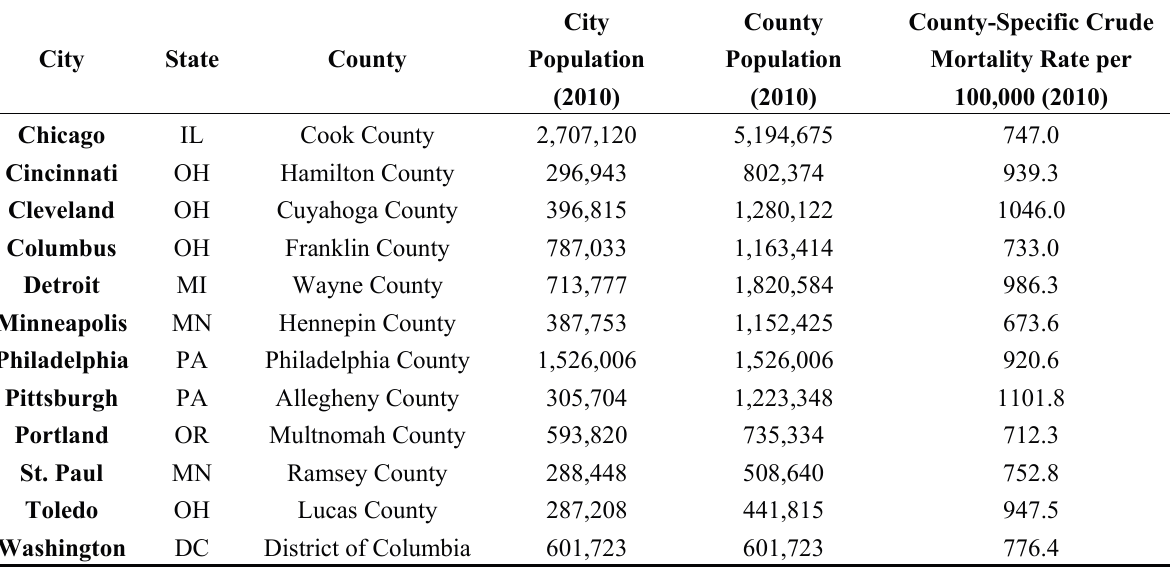
Table 2. City populations and county-specific mortality